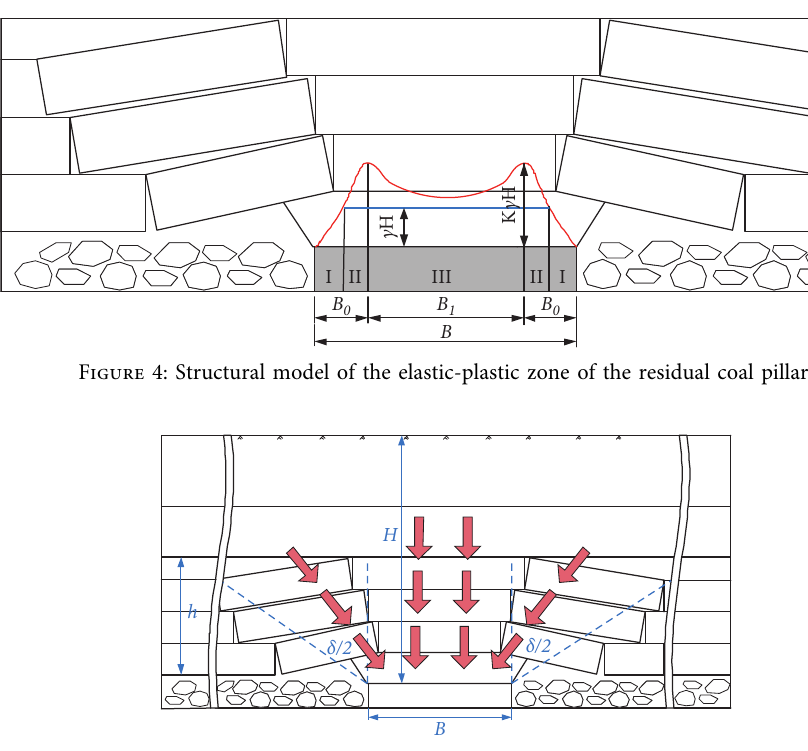
Figure 5: Calculation model of the concentrated load above the residual coal